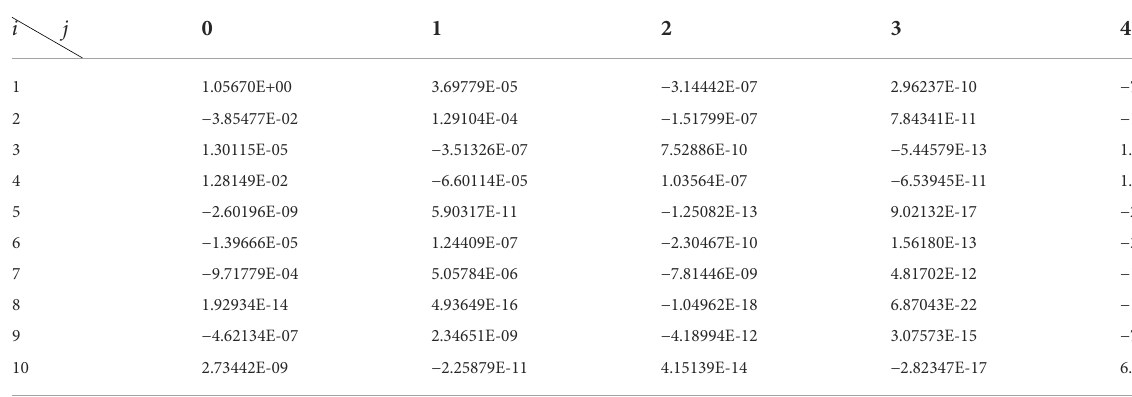
TABLE 2 Value of A π i , j .